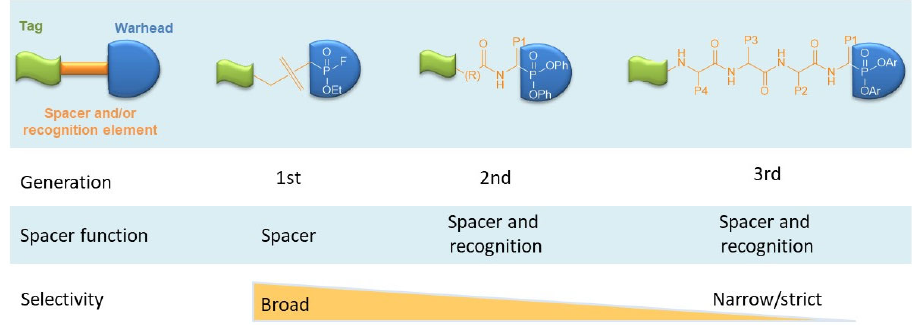
Figure 2. Chemical formulas of warheads used to target proteases. Phosphonates are the classical Figure 3. Transition from first to third generation phosphonate ABPs. Incorporation of a longer warheads for targeting serine proteases and acyloxymethyl ketones for cysteine proteases. ( A ), ac ‐ recognition element in the ABP molecule results in improved specificity. Notably, first generation tivated ketones. ( B ), phosphonates. ( C ), epoxides. ( D ), Michael acceptors . phosphonate ABPs target hydrolases including proteases.